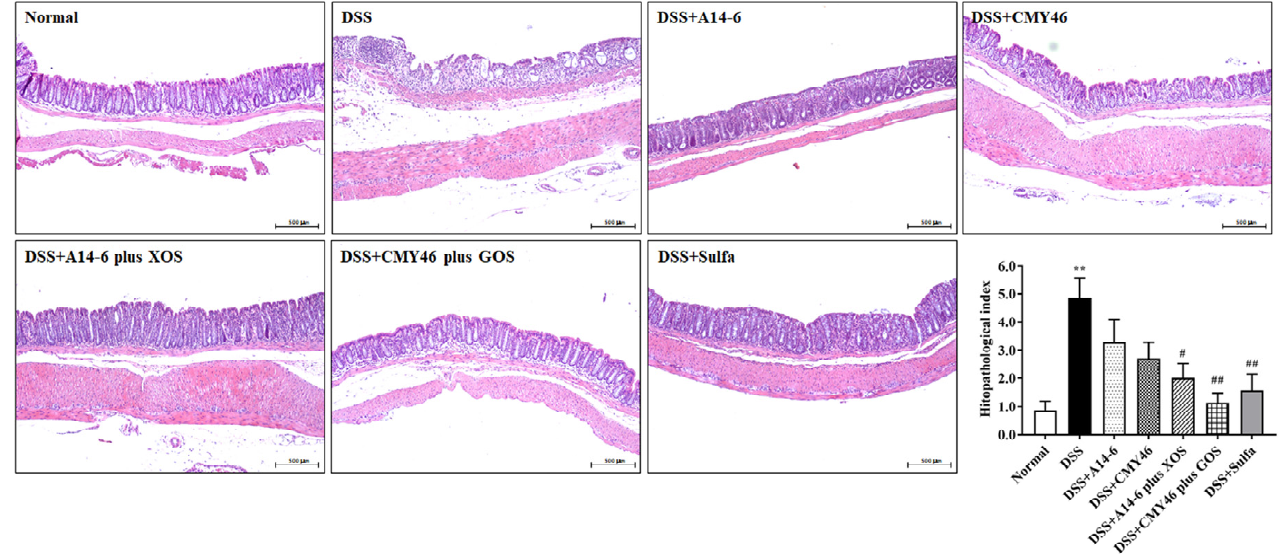
Figure 3. The effect of probiotics and synbiotics on DSS-induced histopathological damage in the colon. Histological images of distal colonic tissues stained with H and E in each experimental group and histopathological index was analyzed under light microscopy. The samples were observed at × 100 magnification. Data expressed as mean ± SEM ( n = 7), ** p < 0.01 vs. normal group. # p < 0.05; ## p < 0.01 vs. DSS